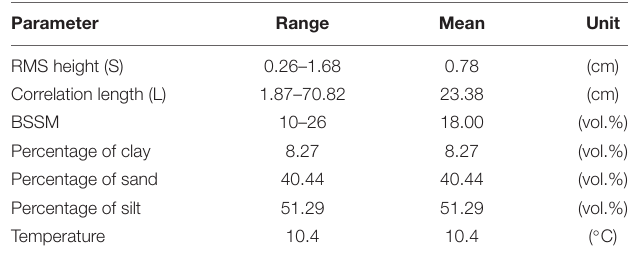
TABLE 2 | Description of the collected of soil parameters from 147 sampling